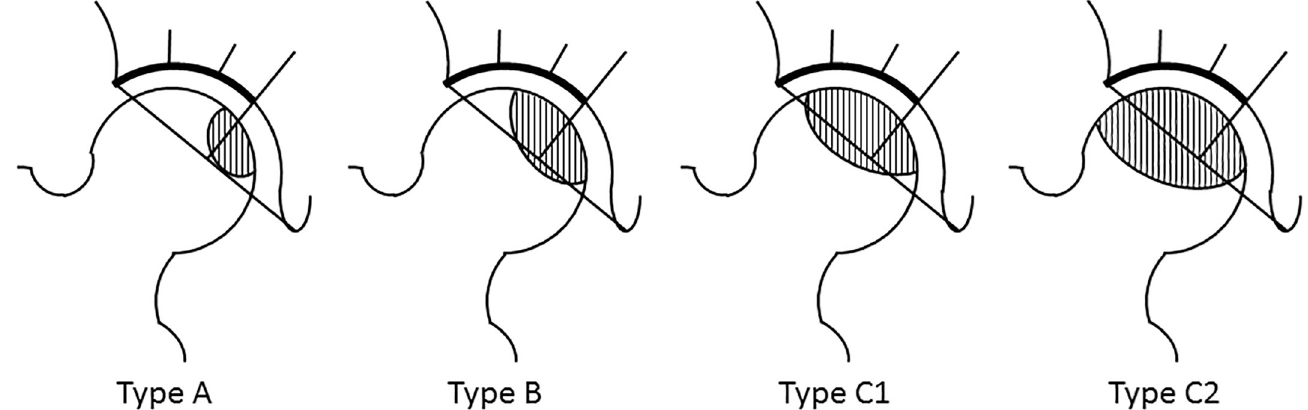
Fig 1. The classification of osteonecrosis of femoral head (Japanese Investigation Committee of Health and Welfare).